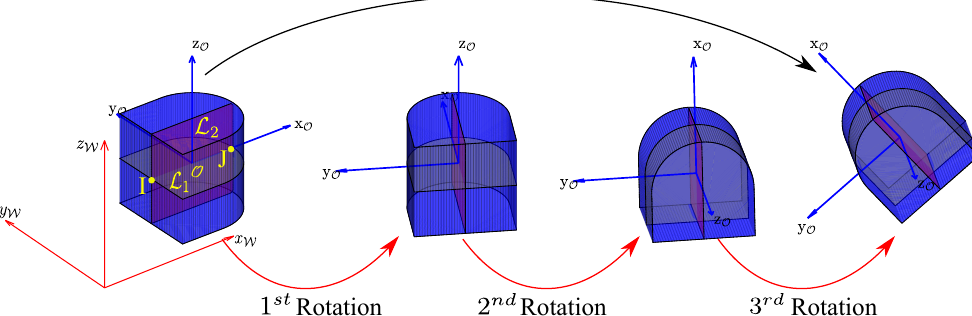
Figure 2. Example of a decomposition of 3-D rotation into three successive rotations, where red and blue reference frames represent world frame and object frame, respectively. The first rotation consists in R ( Z O , θ 1 ) over P 1 , the second rotation is R ( Y O , θ 2 ) over P 2 , and the third rotation is defined by R ( Z O , θ 3 ) over P 1